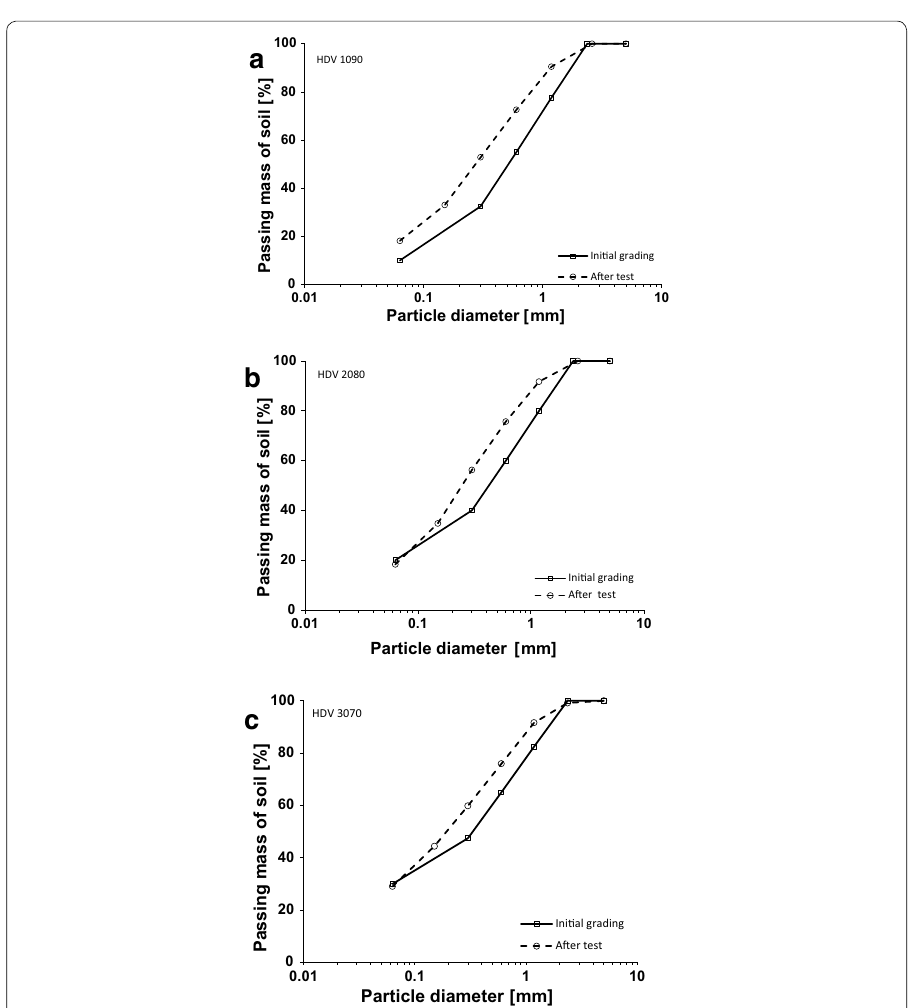
Fig. 11 Change in grading resulting from particle breakage after compression for the HDV. a 1090, b 2080 and c